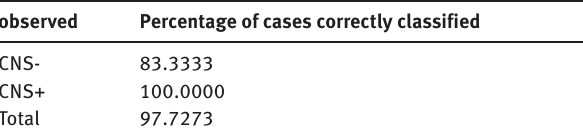
Table 5: Cross-validation matrix.